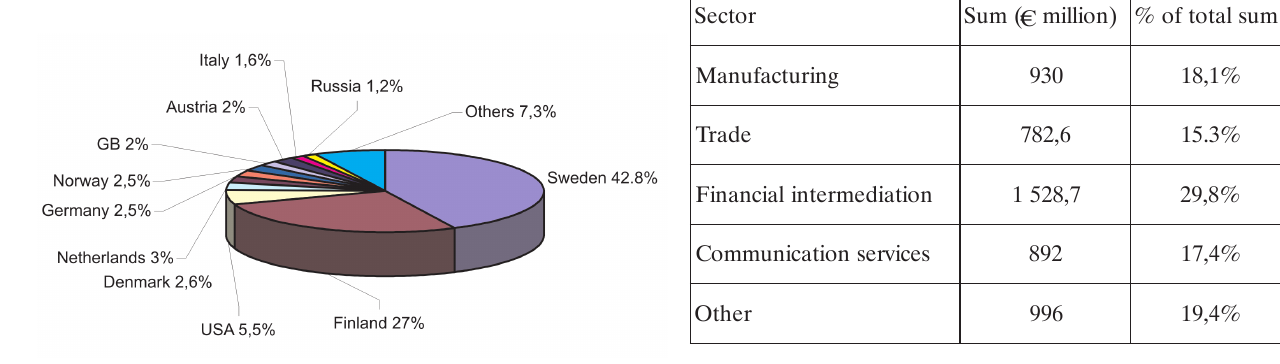
Cumulative FDI in Estonia by countries, 2004 (% of total)